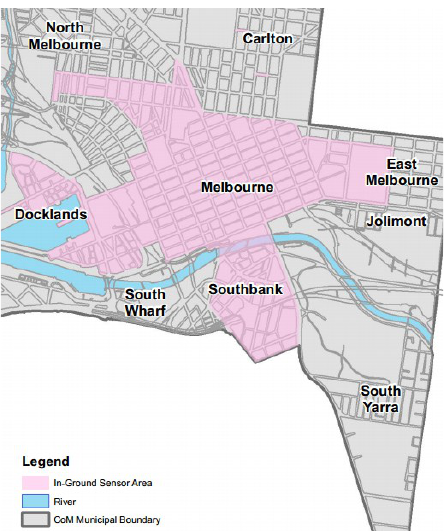
Figure 1. Melbourne in-ground parking sensor map. Source: Victoria State Government, City of Melbourne [14].